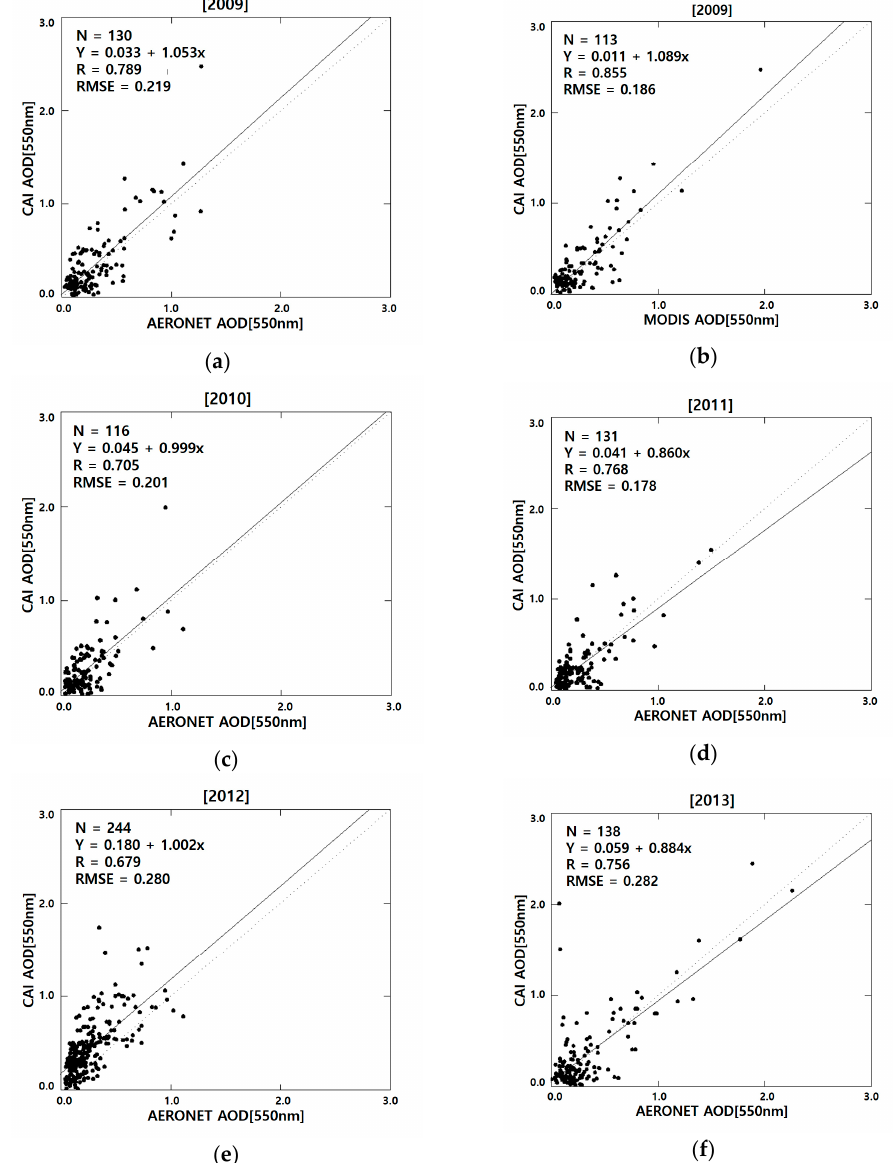
Figure 6. Comparisons of AODs retrieved from the TANSO-CAI aerosol algorithm with those from the AERONET sun-photometers at 0.55 μ m over Northeast Asia ( a ) from June to December, 2009; ( b ) Comparison of AODs retrieved from the TANSO-CAI aerosol algorithm with those from the Aqua/MODIS (Collection 6) collocated within 0.3° latitude × 0.3° longitude grid centered AERONET site over the Northeast Asia from June to December 2009; All year comparisons are shown in ( c ) 2010; ( d ) 2011; ( e ) 2012; and ( f ) 2013. The solid and dashed lines represent the linear regression and one-to-one lines, respectively.